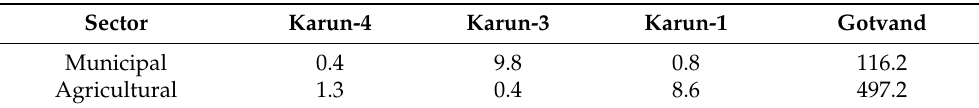
Table 2. Municipal and agricultural demands